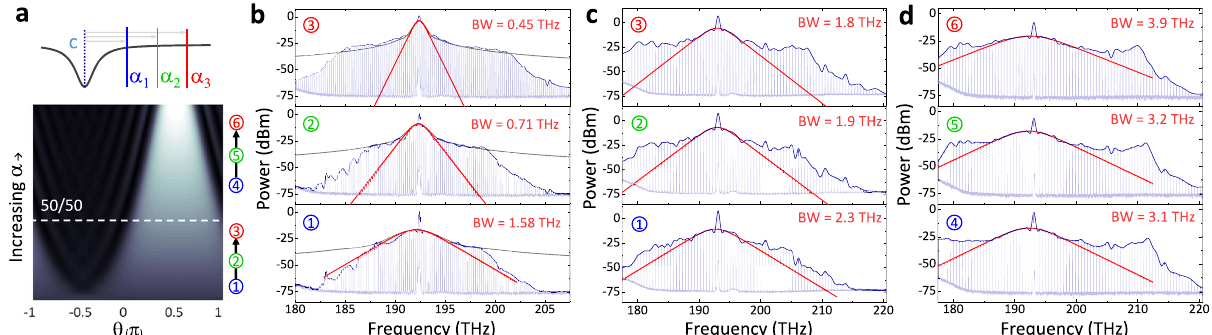
Fig. 4 Spectral tuning. a Illustration of a detuning sweeps toward (1 → 3) and away from (4 → 6) the half- fi lled state (white dashed line), where both sweeps are from high to low frequencies ( α 1 → α 3 ). The color scale is identical to Fig. 1 b . b Measured spectra in a FSR = 200 GHz PhCR showing the center lobe bandwidth (BW, fi tted red trace) decreasing with increasing detuning. The spectral envelope of a square wave (gray) is plotted for comparison. c , d show spectra from nominally identical FSR = 500 GHz rings, but with peak-to-peak PhC amplitude of 8 nm and 12 nm, resulting in ϵ = 4.5 and 5.9 κ , respectively. This places soliton behavior of the two PhCRs on opposite sides of the half- fi lled state and an opposing BW dependence on α . Moreover, prominent horn features appear in ( d